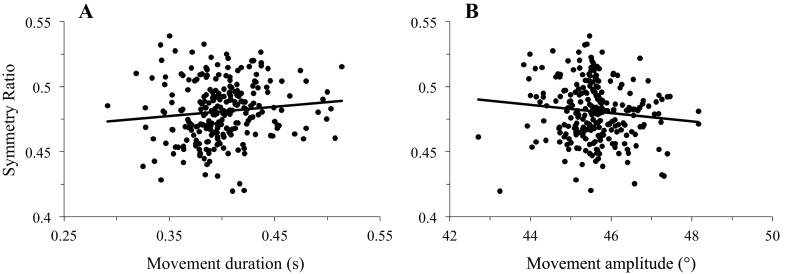
Supplemental analyses testing the effect of movement duration and amplitude on experimental findings.Each data point represents the mean of 12 trials for one subject in one direction (n = 255 in each plot; 3060 trials total). (A) Symmetry ratio as a function of movement duration. (B) Symmetry ratio as a function of movement amplitude. These two plots reveal that the symmetry ratio was independent of movement duration (individual correlation coefficients averaged R = 0.22 [min: 0.04, max: 0.57], p=0.41) and amplitude (on average R = 0.29 [min: 0.02, max: 0.69], p=0.26); therefore ensuring that the modulation of arm kinematics observed in Figure 2 truly reflects gravity torque effects.